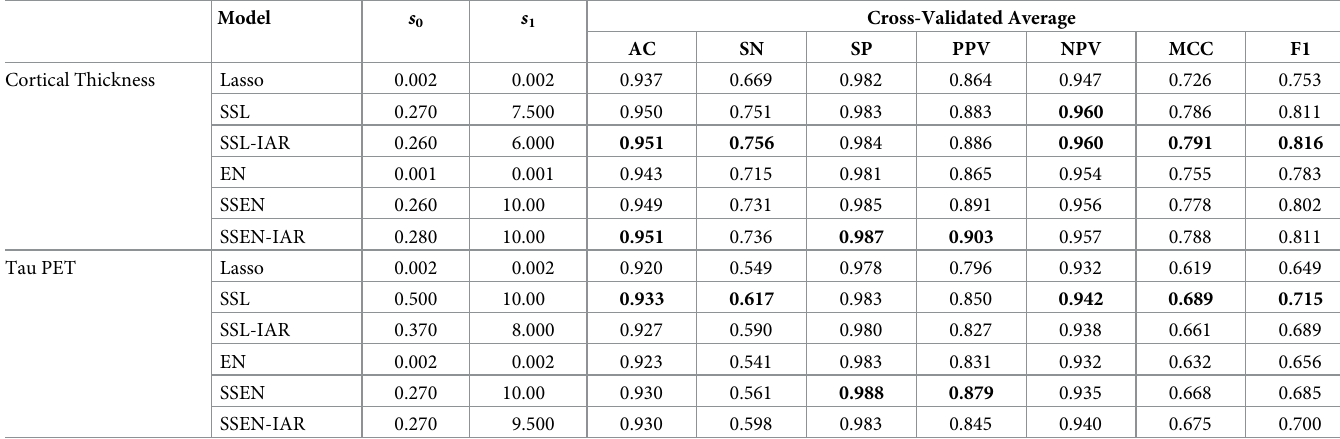
Table 2. ADNI: Classification performance.